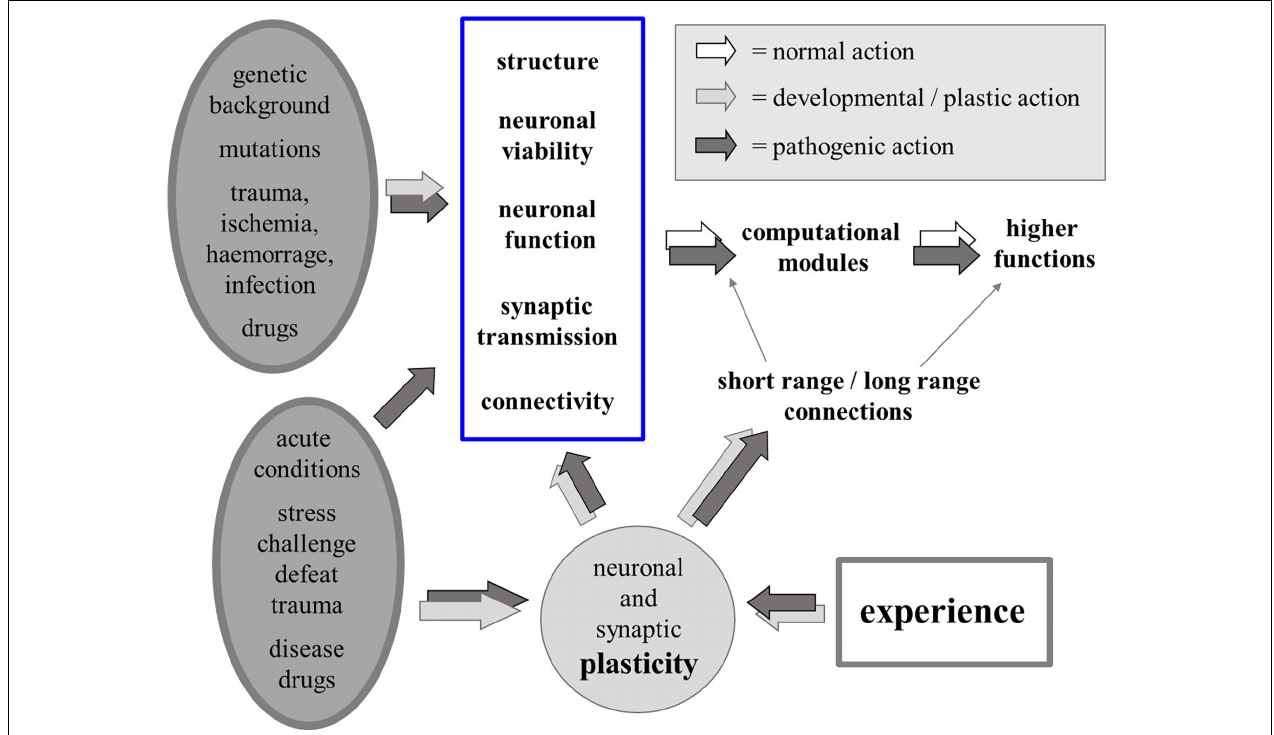
FIGURE 3 | Physiological and pathological biological factors (chronic or acute; left-hand side) may alter neuronal structure, viability, function and connectivity, affecting the function of computational modules in the brain and short as well as long-range connectivity. Due to experience-driven neural plasticity, “biological” (organic) and “psychogenic” (experience) factors may similarly affect the function of the computational modules and the higher functions that result from the interactions among such